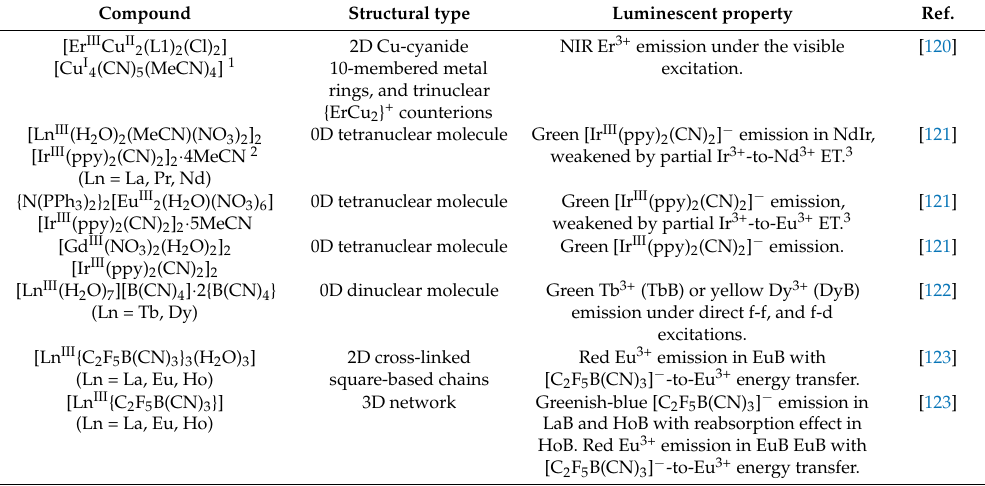
Table 6. Photoluminescent coordination compounds composed of lanthanide ions and other cyanide-containing building blocks.